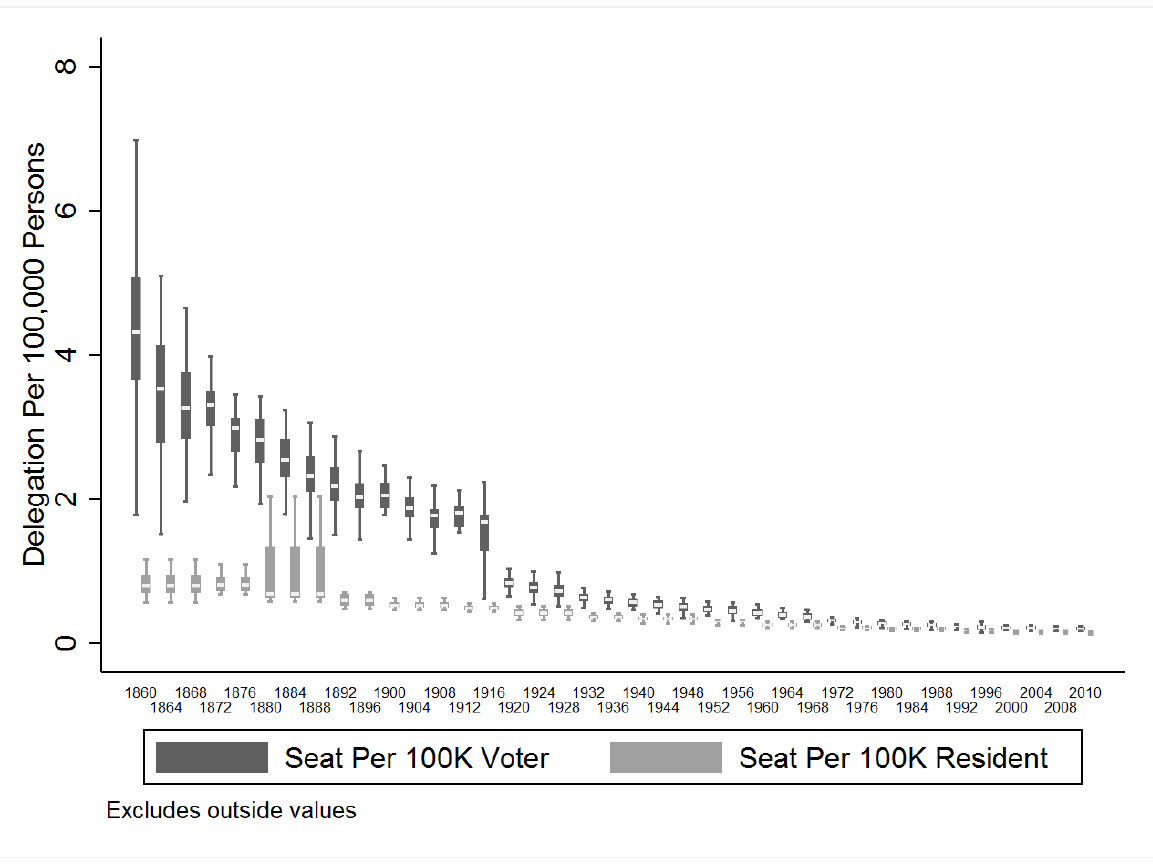
Figure 1: House seats per 100,000 eligible voters by state and House seats per 100,000 residents by state from 1860 to